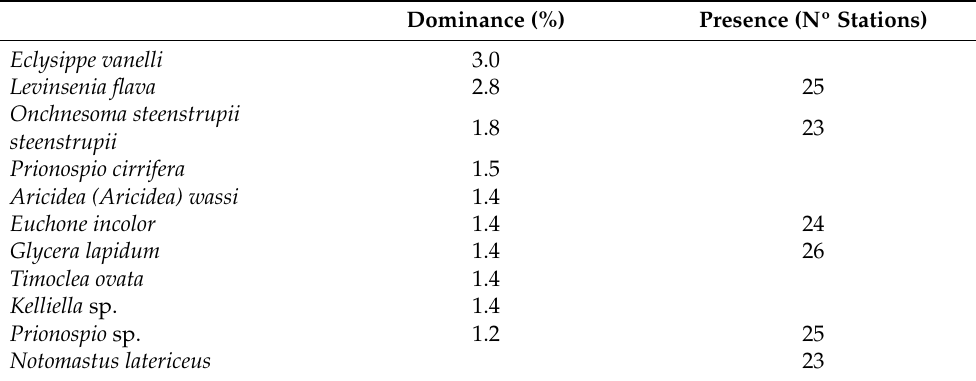
Table 1. Dominant species which accounted for more than 25% of abundance of all individuals, together with species present on more than 20 stations. Dominance (%) Presence (Nº